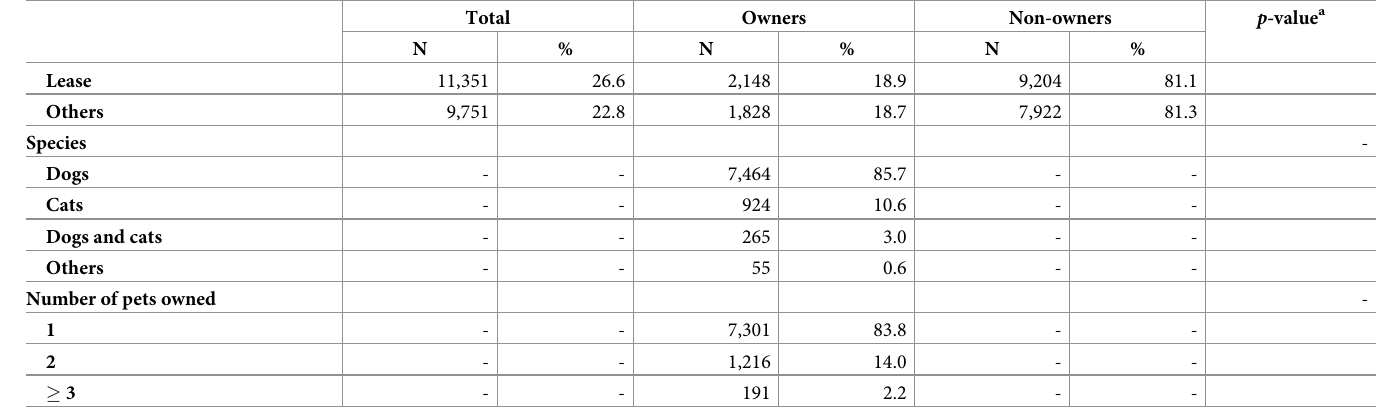
(0.6%). With respect to the number of pets owned, 7,301 participants (83.8%) owned only one animal, 1,216 (14.0%) owned two animals, and 191 (2.2%) owned three or more animals. Table 2 presents the results of descriptive analysis, independent samples t -test, and ANOVA on overall life satisfaction within total population, owners’ group, and non-owners’ group. Overall life satisfaction scores of the total population ranged from 2–80. Owners (Mean [M] = 56.02, Standard Deviation [SD] = 10.25) displayed higher average overall life satisfaction levels than non-owners (M = 54.79, SD = 10.68). In the overall population, males, singles, white-collar workers, and those having higher edu- cation, living in an apartment, and owning a house showed higher levels of overall life satisfac- tion. Additionally, overall life satisfaction generally decreased with age, while it increased with growth in household income. However, single-member households displayed the lowest aver- age overall life satisfaction. Age, sex, marital status, family size, family income, job, education, type of housing, and housing tenure type were associated with significant differences in the overall life satisfaction levels among the pet owners’ group and among non-owners’ group (all p < 0.05). Average overall life satisfaction among dog owners decreased with an increase in the num- ber of pets owned (single pet owners: M = 56.14, SD = 0.13). Similarly, among cat owners, sin- However, among owners who raised both dogs and cats, those with three or more pets reported higher overall life satisfaction levels (M = 59.07, SD = 1.02) than those with two pets (M = 58.05, SD = 0.67). In other words, owners of both dogs and cats showed the highest aver- age overall life satisfaction levels, followed by single pet owners of either a cat or a dog. Propensity score matching reduced the imbalance of covariates (S1 Table). The matched data comprised 8,654 pet-owners and 17,293 non-owners. Table 3 presents the results of the multiple linear regression analyses conducted using matched data to identify the association between pet ownership and overall life satisfaction. The model indicated no multicollinearity among the independent variables (VIF < 4). Pet to be positively associated with overall life satisfaction, even after accounting for the unob- served heterogeneity between owners and non-owners. Thus, pet owners reported higher overall life satisfaction levels than